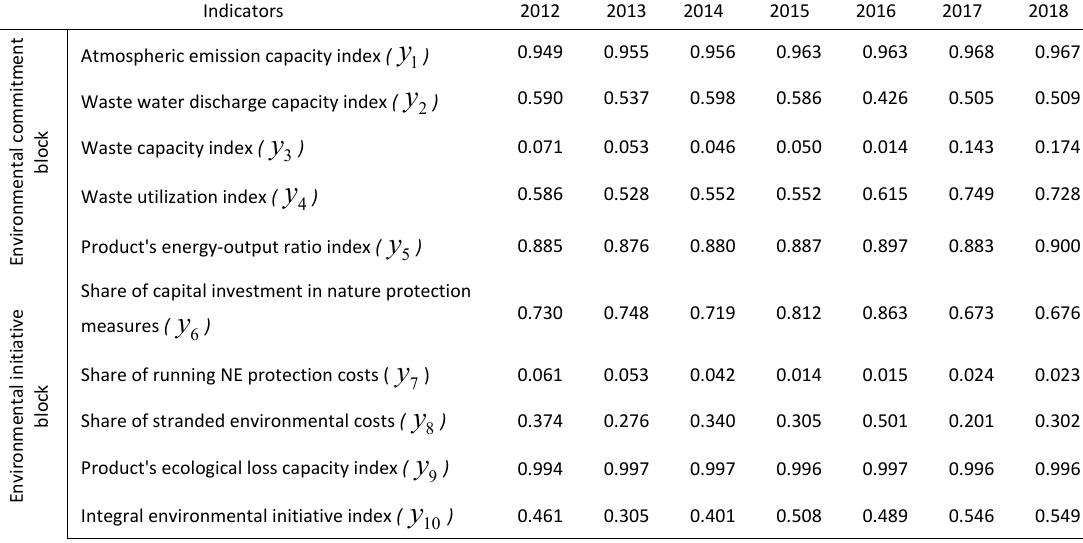
Table 6: Observation matrix for the assessment of environmental responsibility